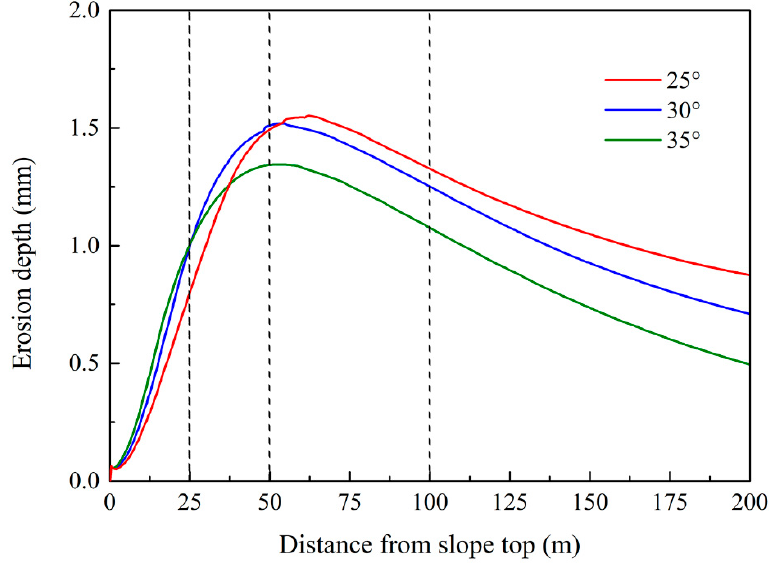
Figure 11. The erosion depth distribution along the slope axis under rising-falling rainfall at 25°–35° slopes.